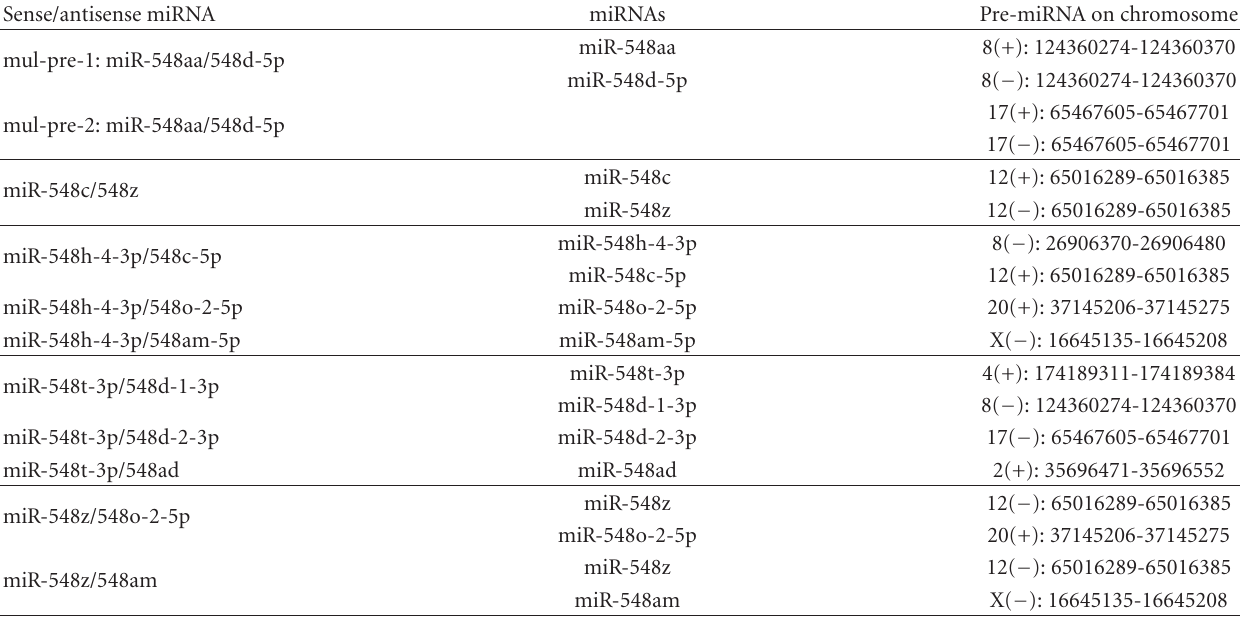
Table 2: miRNA:miRNA interaction in hsa-mir-548 gene